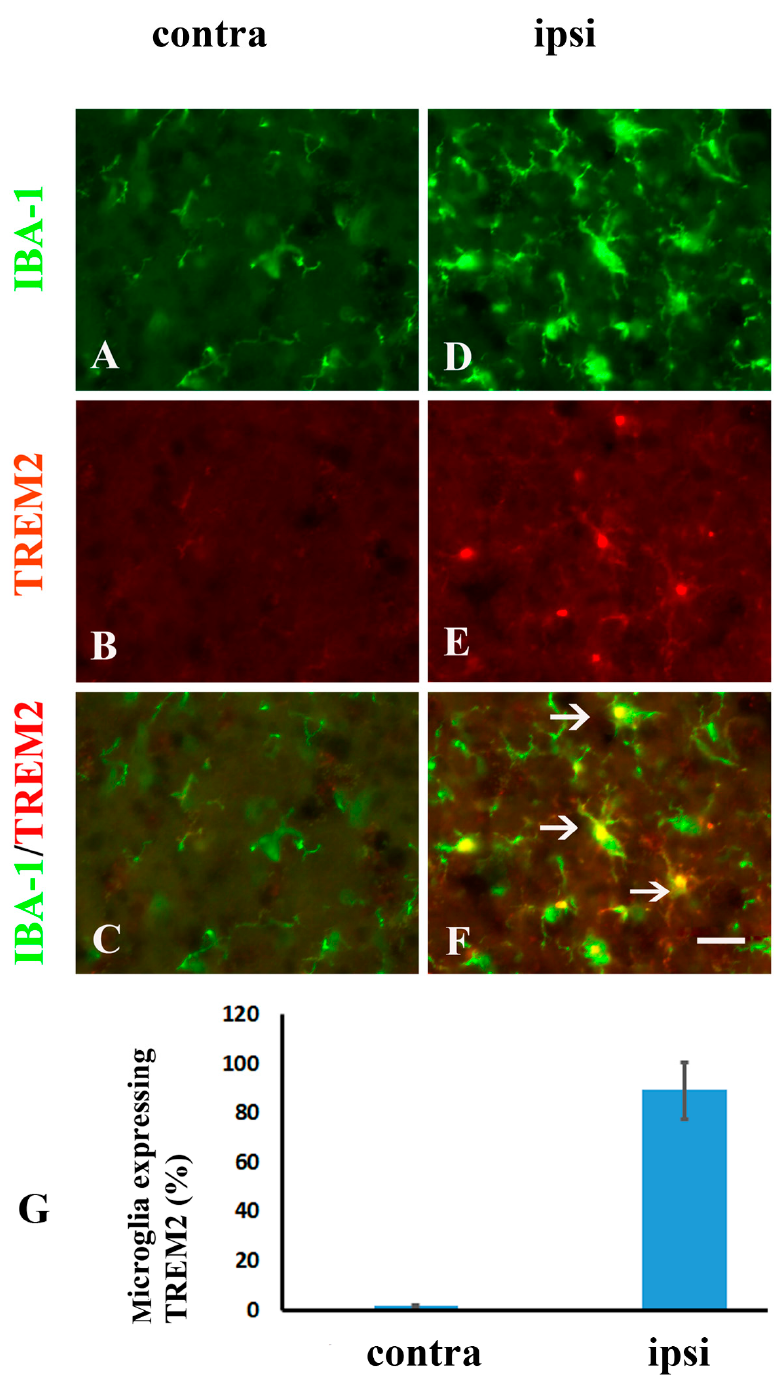
Figure 5. Double labeling of IBA-1(green)/TREM2 (red) in the contralateral (contra) ( A – C ) and ipsilateral (ipsi) ( D – F ) sides of the spinal cord of the TgCRND8 mice at 7 days postinjury reveals TREM2 is exclusively expressed in activated microglia following nerve ligation (arrows in ( F )). ( G ): Quantitative analysis of microglia expressing TREM2 (%) in the contralateral (contra) and ipsilateral (ipsi) sides. Scale bar, 10 µ